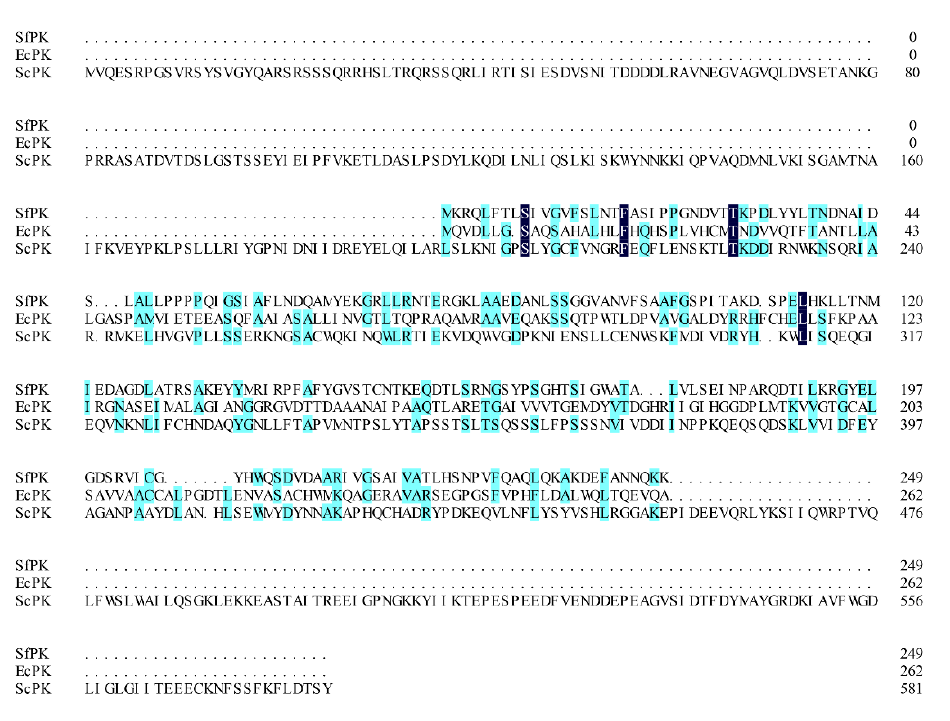
Figure 1. Alignment of promiscuous kinases. SfPK: Shigella flexneri promiscuous kinase, EcPK: Escherichia coli promiscuous kinase, ScPK: Saccharomyces cerevisiae promiscuous kinase.